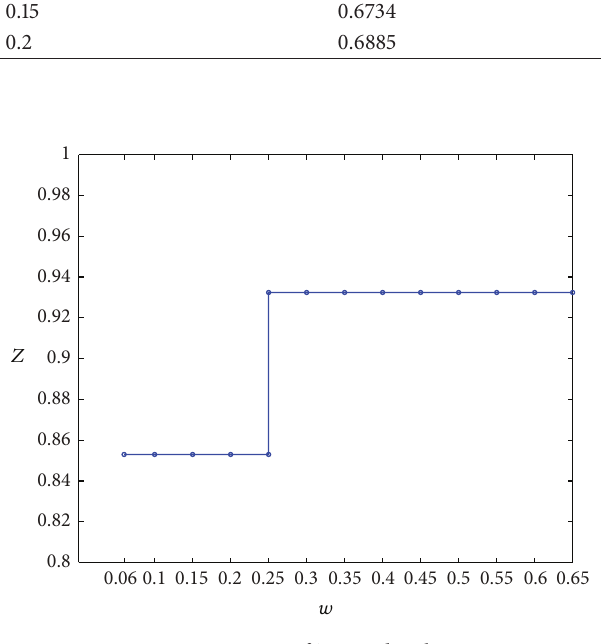
Figure 8: Curve of 𝑍 varied with 𝑤 . Figure 9: Curve of the optimal CODP varied with 𝑤